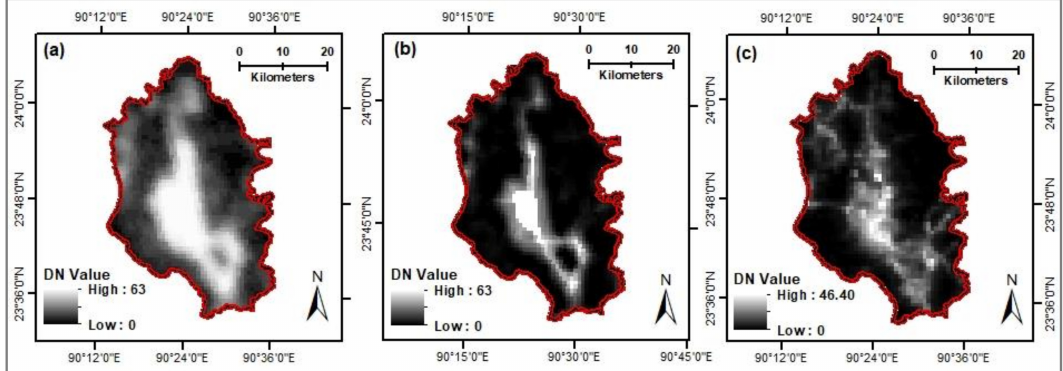
Figure 4. ( a ) The original DMSP-OLS image of 1992 for the DMDP area; ( b ) self-adjusting model (SEAM)-corrected image of 1992 for the DMDP area; ( c ) resampled night-time light (NTL) VIIRS image of 2016 for the DMDP